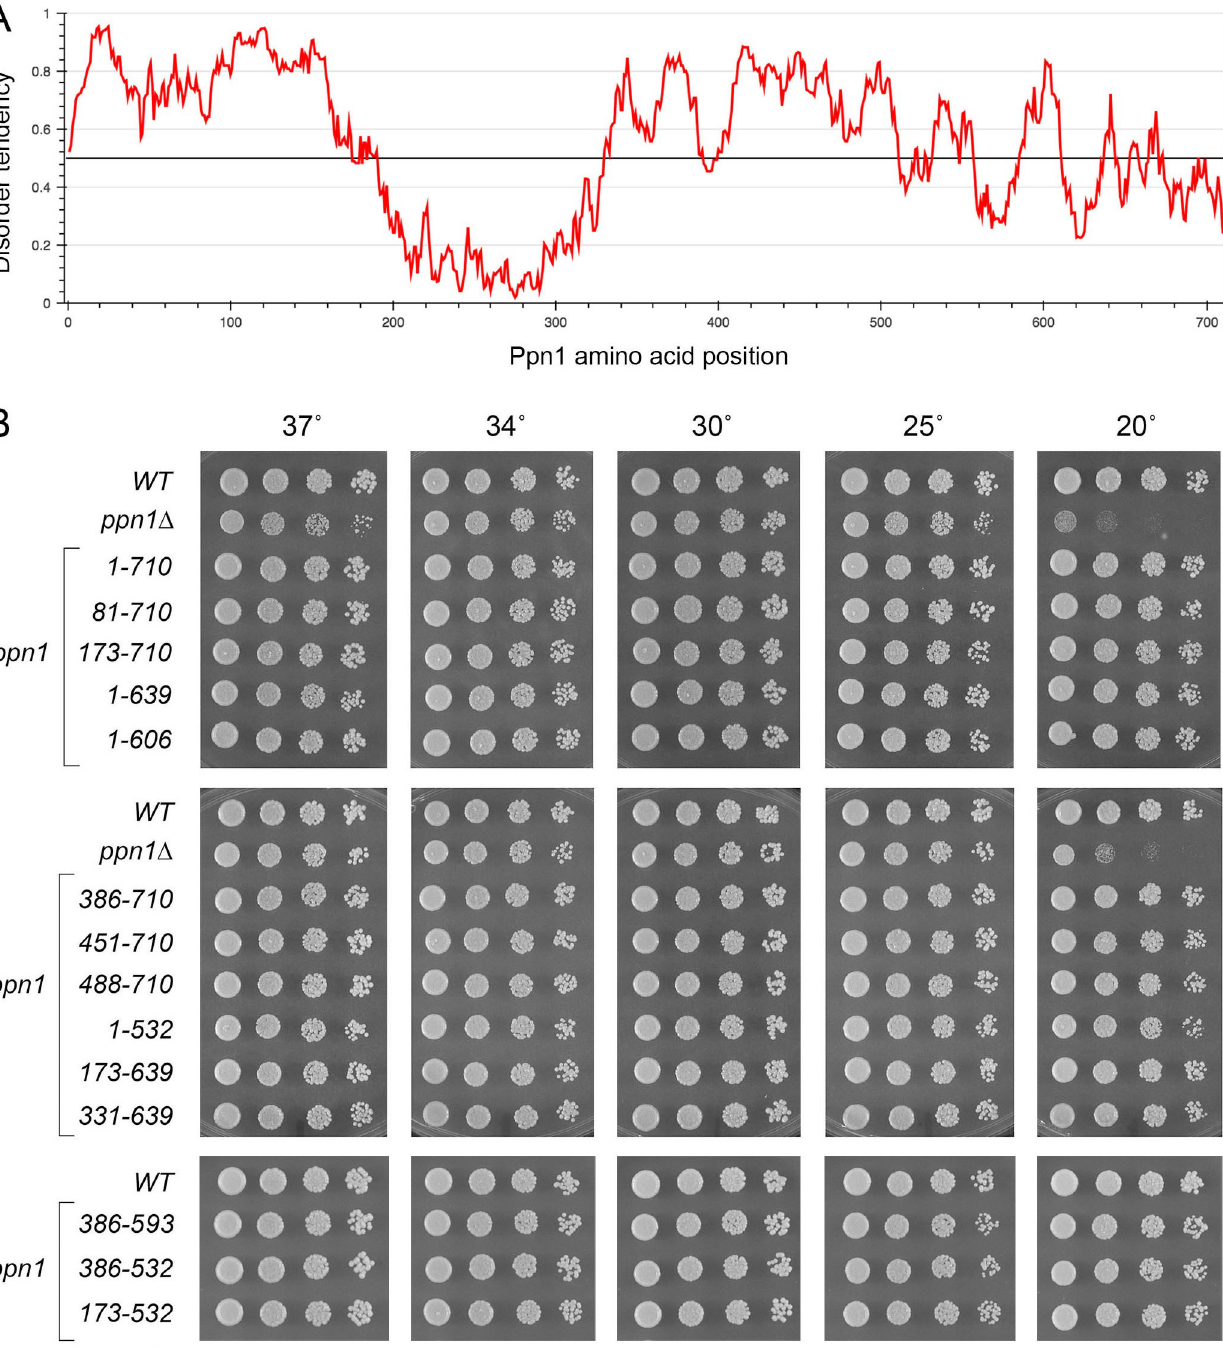
Fig 5. Fission yeast strains with ppn1 truncation alleles. (A) An IUPred2A plot of disorder tendency by position in the S . pombe Ppn1 primary structure. (B) Serial dilutions of cultures of wild-type ( WT ), ppn1 Δ , and the indicated ppn1 truncation mutants were spot-tested for growth on YES agar at the temperatures